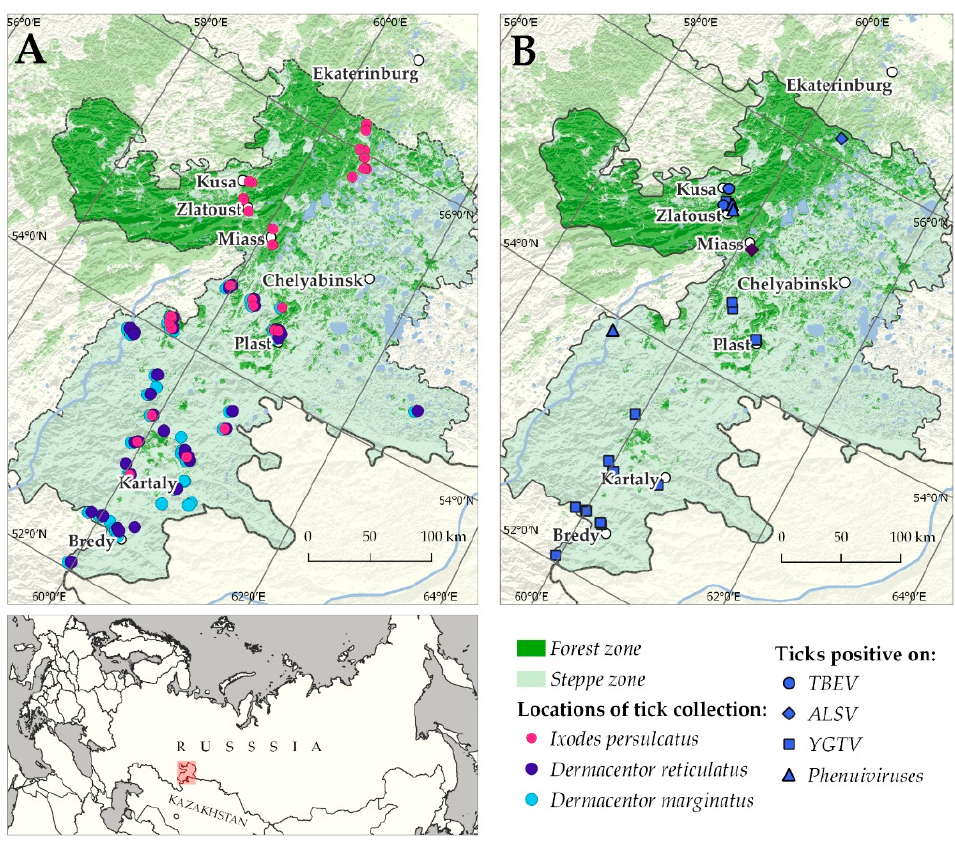
Figure 1. The map of the Chelyabinsk region. ( A ) . Locations of tick collections in the Chelyabinsk region. ( B ) . Locations of detection of TBEV, Yanggou tick virus, Alongshan virus, and phenuiviruses in the Chelyabinsk region. ALSV near city Miass (purple rhombus, B ) was described previously [23,33].